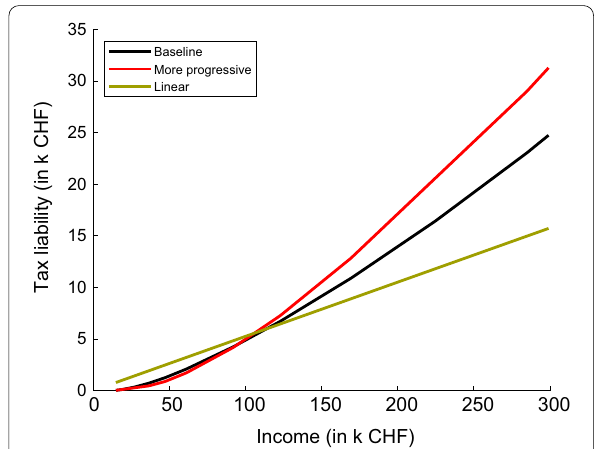
Fig. 4 Changing the progressive tax scheme: tax liability per income